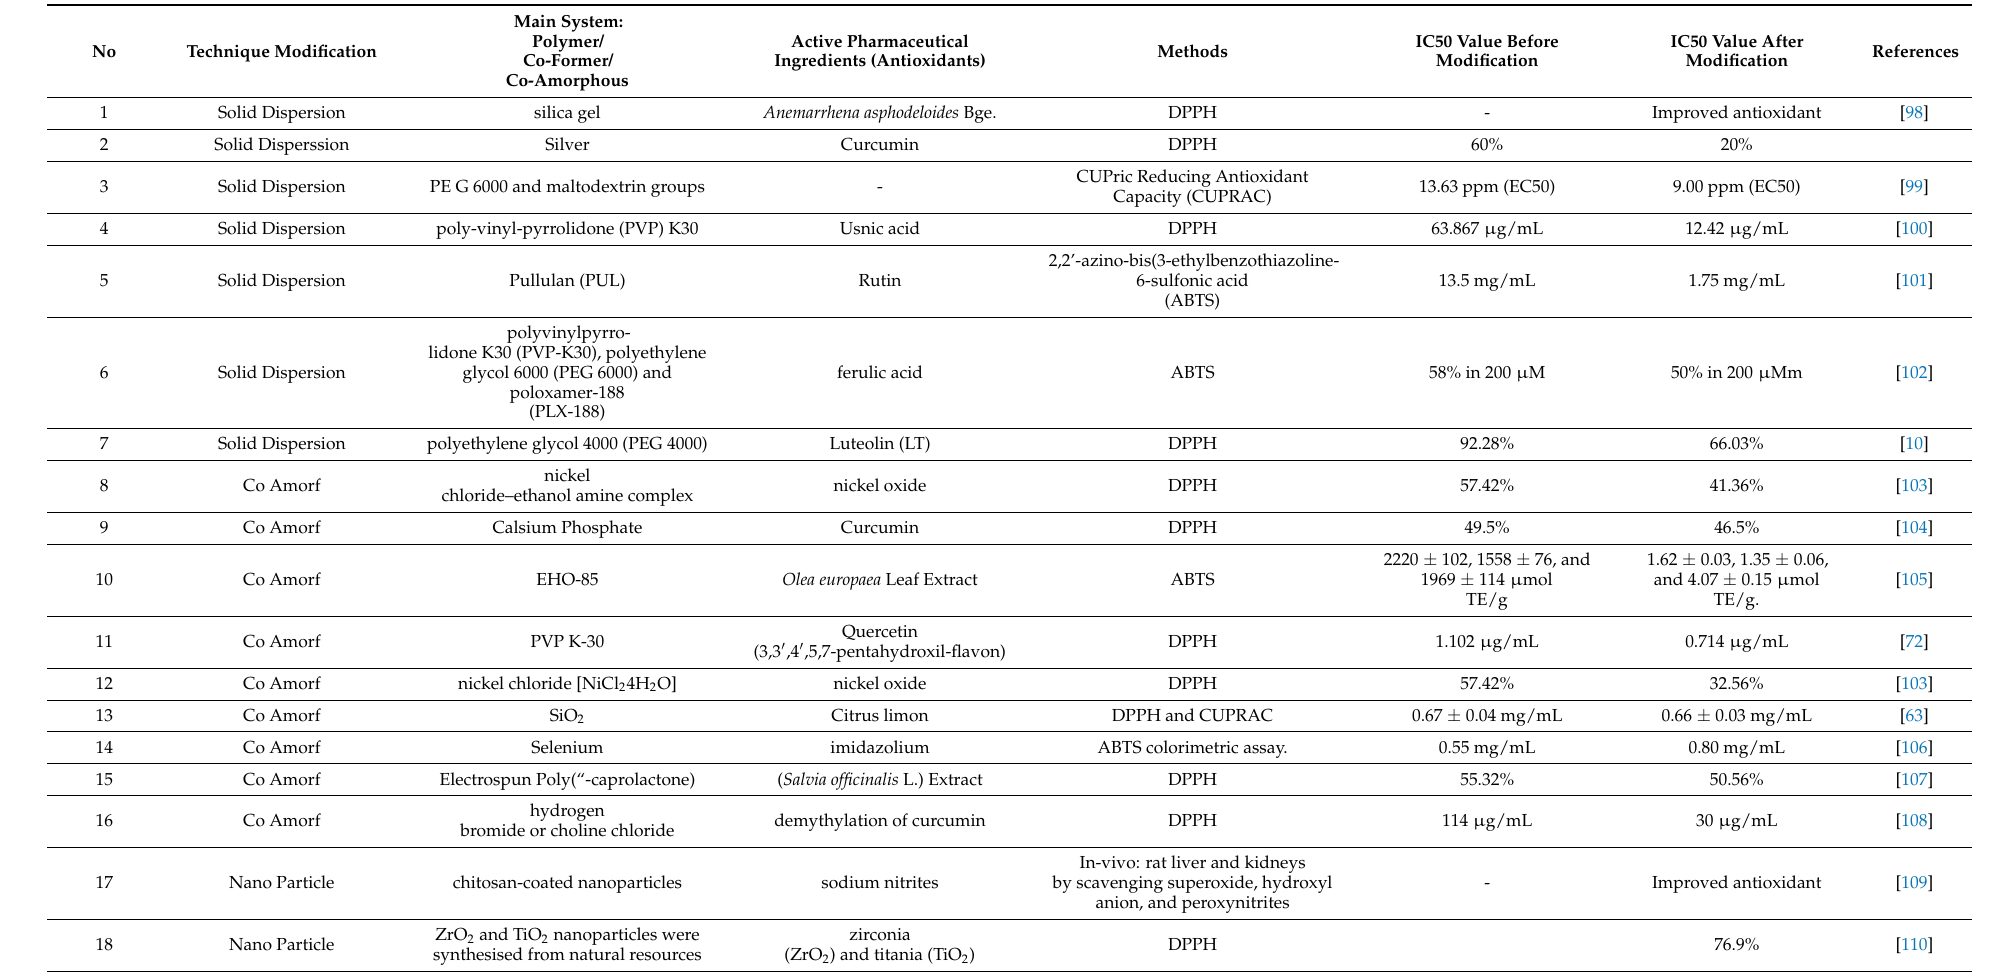
Table 2. Water Solubility Improvement Strategies of Poorly Soluble